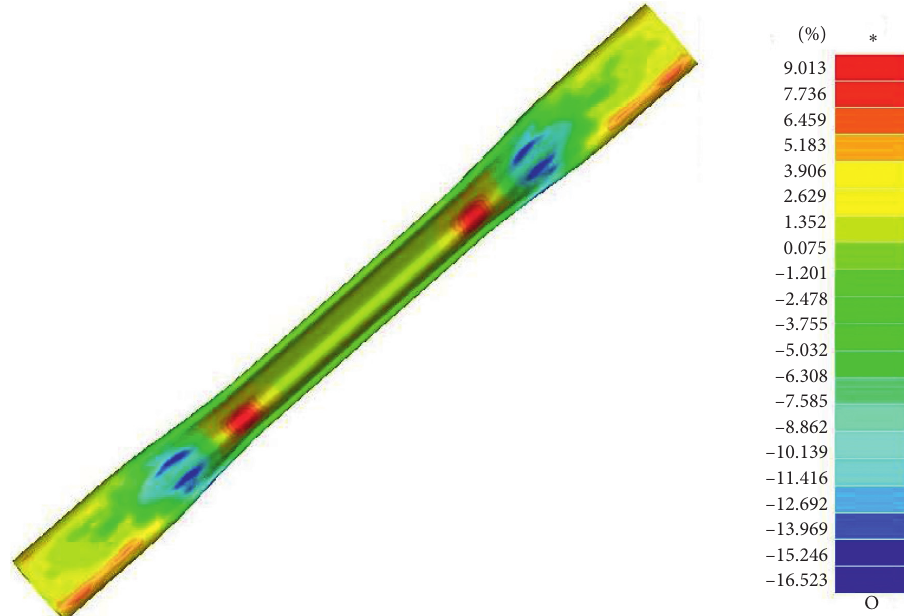
Figure 21: Nephogram of thinning rate of A